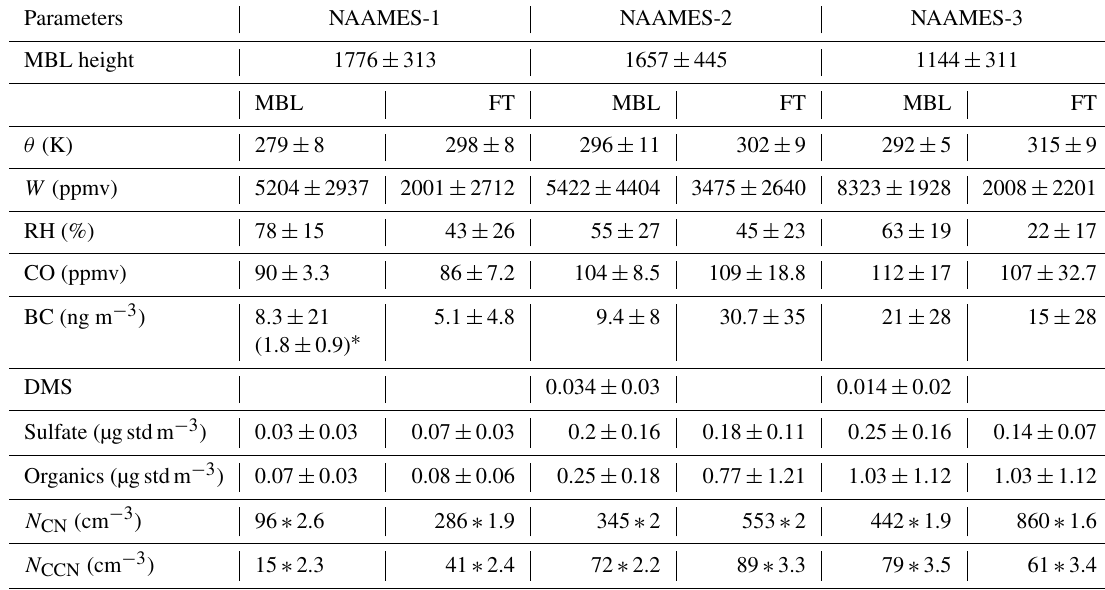
Table 3. Summary statistics of meteorological parameters, trace gases, and aerosol properties measured during the three NAAMES field campaigns. The numbers are shown as mean ± standard deviation. N CN and N CCN values indicate geometric mean ∗ geometric standard